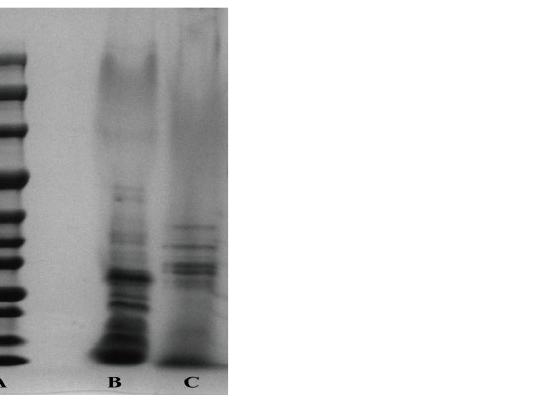
Figure 6. SDS-PAGE protein electropherogram to detect the protein composition of extracellular products of A. salmonicida . Note: A—protein marker; B—wild-type strain; C— hcp -RNAi strain.